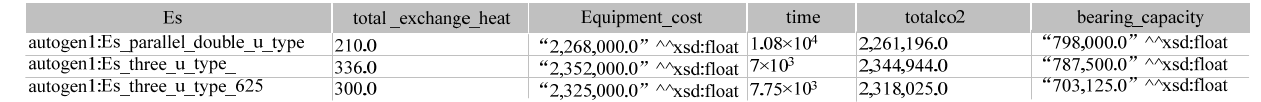
Figure 12. Execution and results of querying R.2 in Table 4.